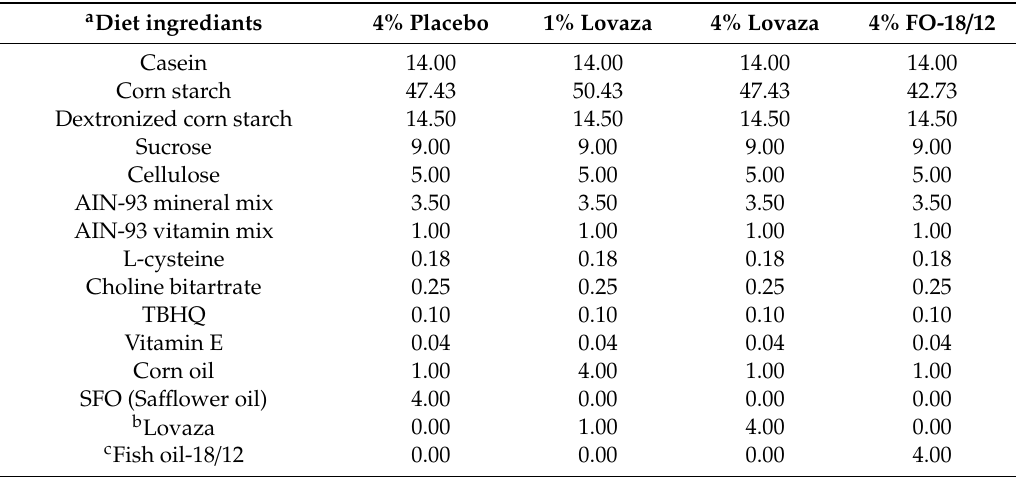
Table 1. Composition of AIN-93 semi-purified diets containing sa ffl ower oil (SFO), concentrated fish oil (CFO) and regular fish oil (FO-18 /